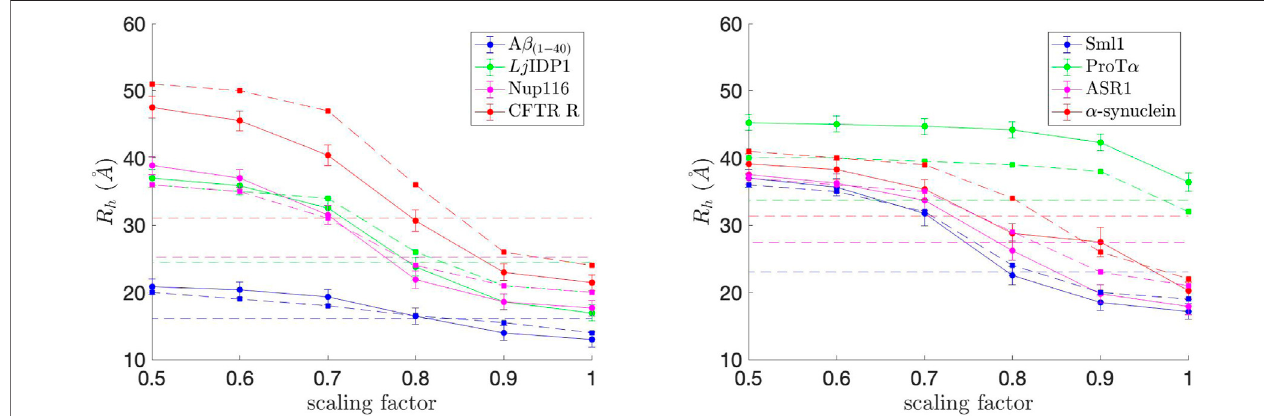
FIGURE 4 | Hydrodynamic radius ( R h ) values for each of the eight naturally occurring IDPs with different scaling factors for non-bonded interactions. The experimental R h values are marked as dashed straight lines and correspond to the IDP with the same color in each graph. The approximate R h values from Frembgen- Kesneretal.(2015)aremarkedasdashedlineswithsquaremarkersandcorrespondtotheIDPwiththesamecolorineachgraph.Theidealscalingfactorvaluewouldbe where R h matches with the experimental value.